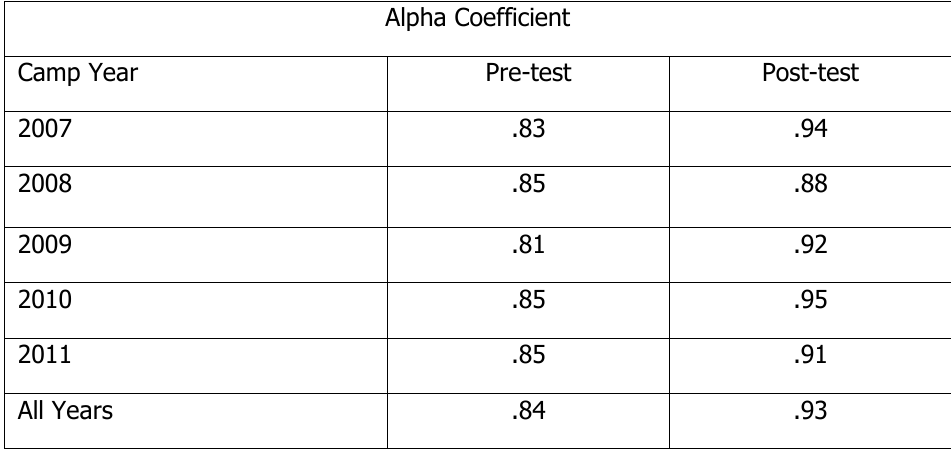
Summary of Alpha Coefficients for Pre and Post-test SPSI by Camp Year